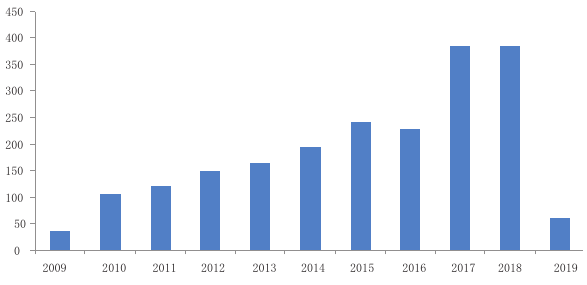
Figure 5. Distribution of citations by years (2008−2019)